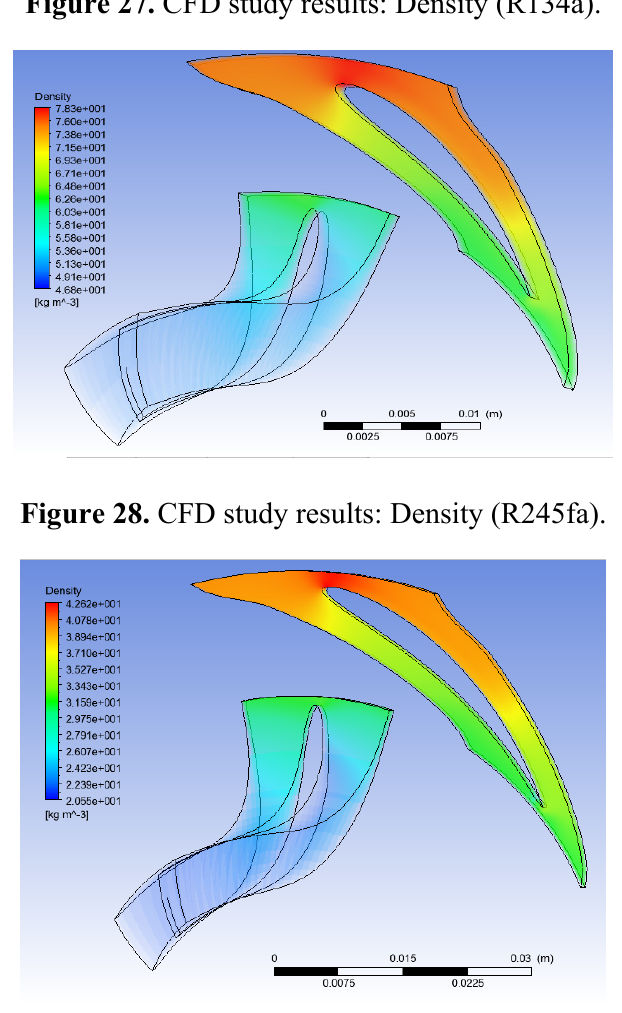
Figure 27. CFD study results: Density (R134a).